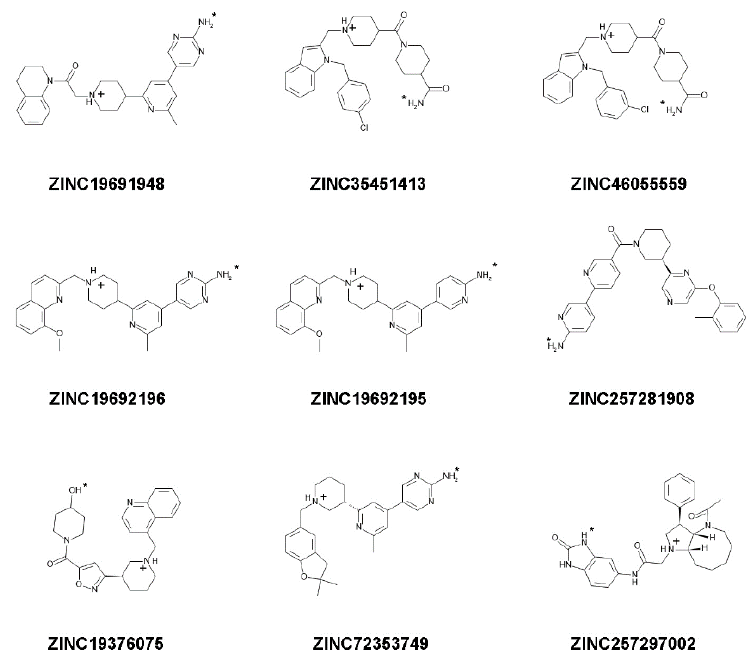
Figure 7. Structure, charge, and protonation at pH 7.4 of candidate ligands that form a hydrogen bond with C-terminus of NMT1. The hydrogen atom involved in the H-bond is highlighted by a small asterisk. This hydrogen atom can be a part of an amino group, hydroxyl group, or indole ring in the different ligands. The positive charge of the molecule is in a centrally located ring substructure and does not engage in formation of a salt bridge (may participate in cation–pi interactions in some cases).